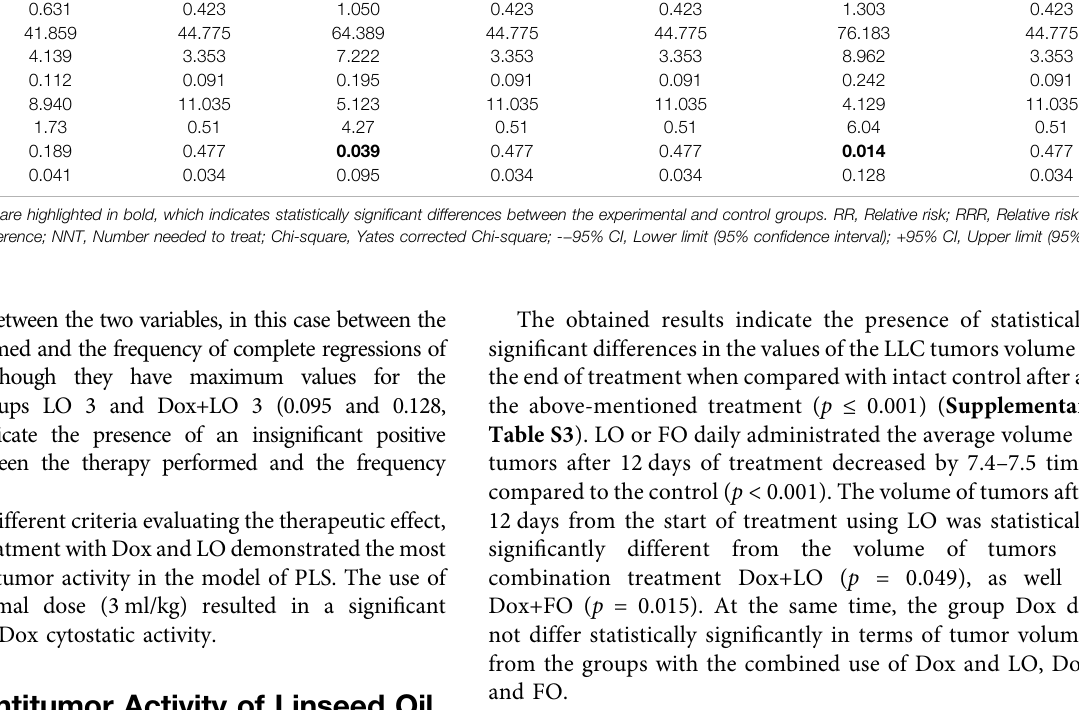
TABLE 2 | Quantitative assessment of the relationship between the treatment performed and the frequency of complete PLS regressions. Parameter